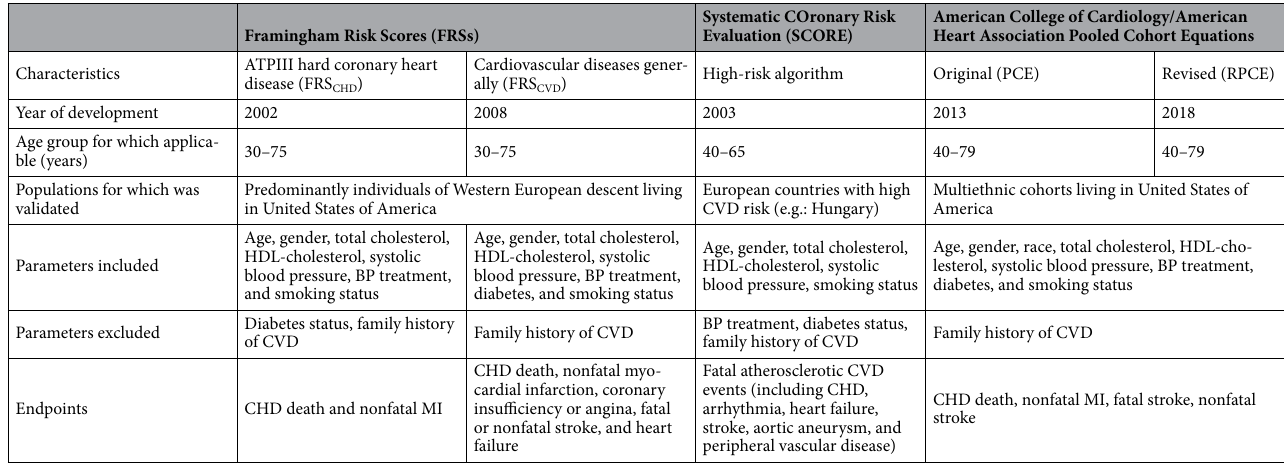
Table 1. Characteristics of cardiovascular risk assessment models used in the